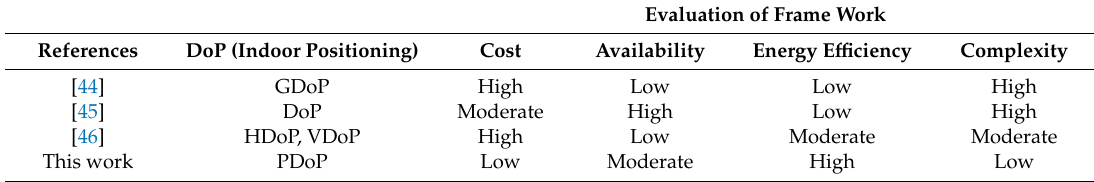
Table 4. Comparative evaluation in terms of application of dilution of precision (DoP) metrics in indoor